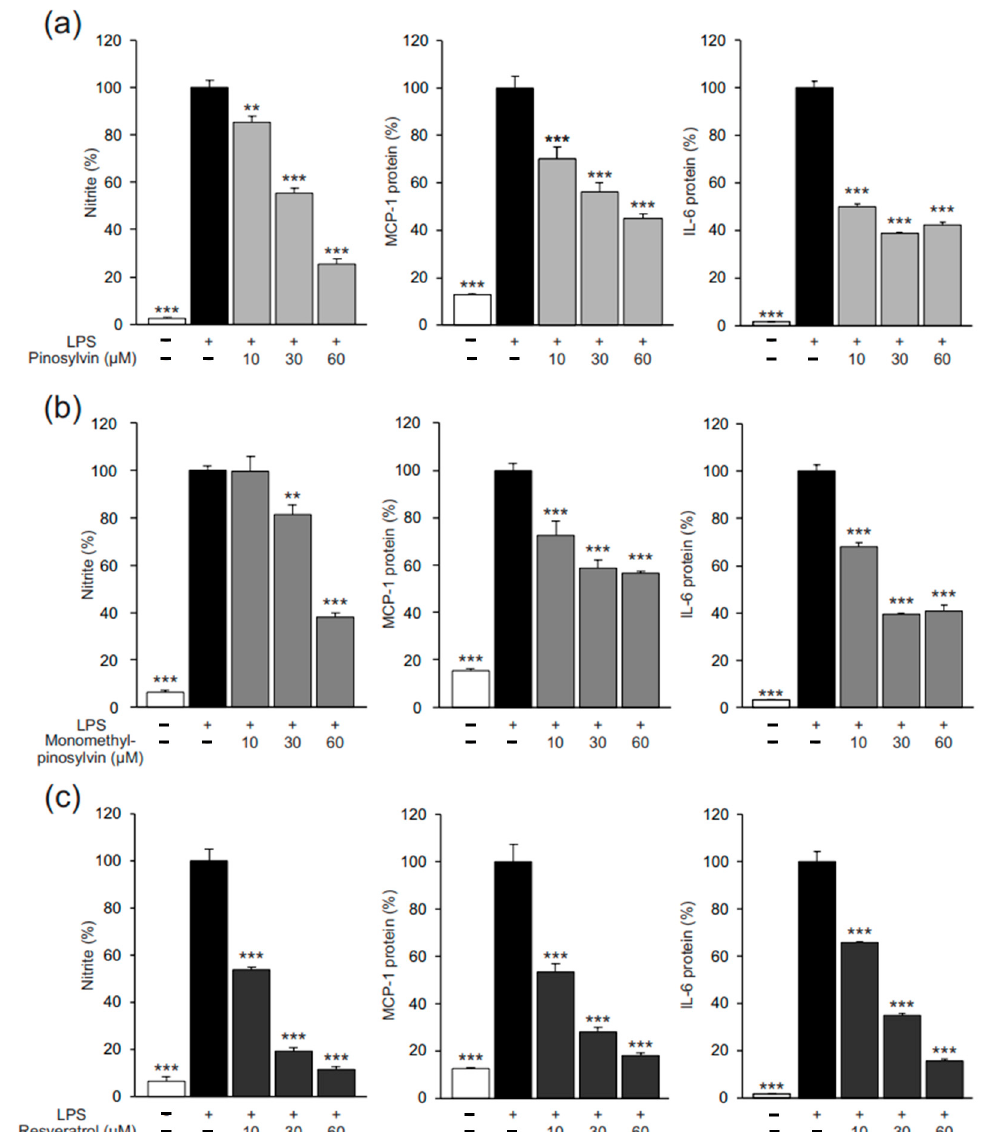
Figure 6. Pinosylvin ( a ), monomethyl pinosylvin ( b ), and resveratrol ( c ) inhibited lipopolysaccharide (LPS)-stimulated expression of markers of classical (M1-type) macrophage activation in J774 murine macrophages. J774 cells were cultured with LPS (10 ng/mL) alone or together with the stilbenoid compounds for 24 h. Nitric oxide (NO) production was measured as its stable metabolite nitrite in the culture medium by the Griess reaction. Monocyte chemoattractant protein 1 (MCP-1) and interleukin-6 (IL-6) concentrations were measured by enzyme-linked immunosorbent assay (ELISA). The results are expressed as mean + SEM, n = 6. Statistical significance of the results was calculated by one-way ANOVA followed by Bonferroni multiple comparisons test. ** = p < 0.01 and *** = p < 0.001 as compared to cells cultured with LPS only, marked as a black bar.